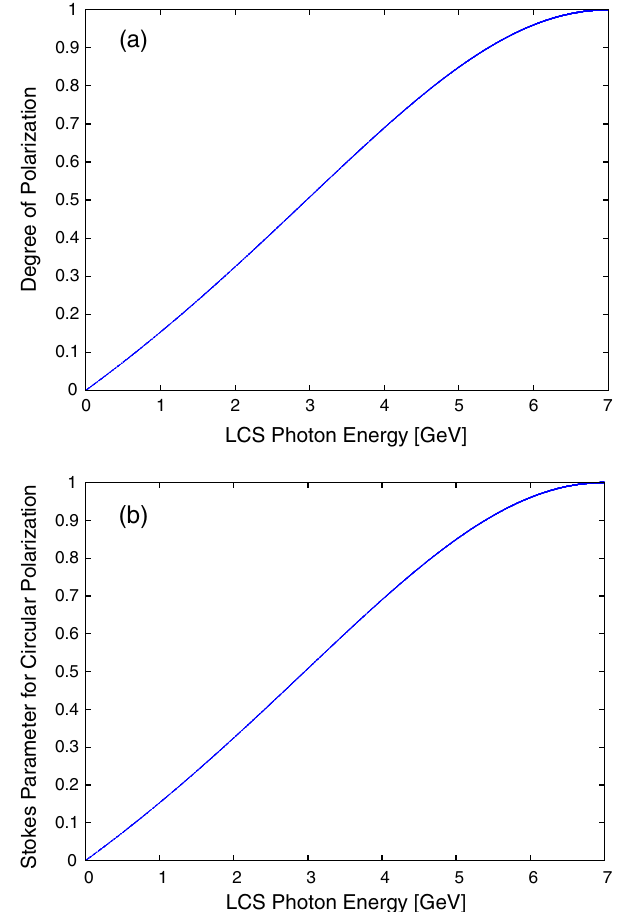
FIG. 7. Results of the CAIN simulation for γ -ray photons generated via Compton scattering with a spin polarized electron beam in the two-mirror XFELO- γ . (a) Degree of polarization, (b) The Stokes parameter for circular